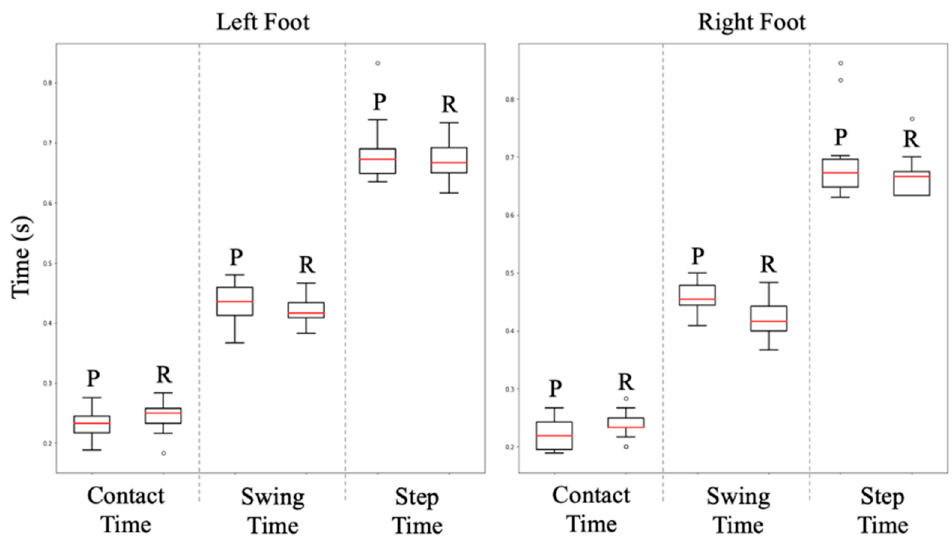
Figure 5. Box plots illustrating the temporal difference between BlazePose predicted ( P ) and reference ( R ) data streams for contact time, swing time, and step time at all speeds, observing the differences between left and right foot outcomes.